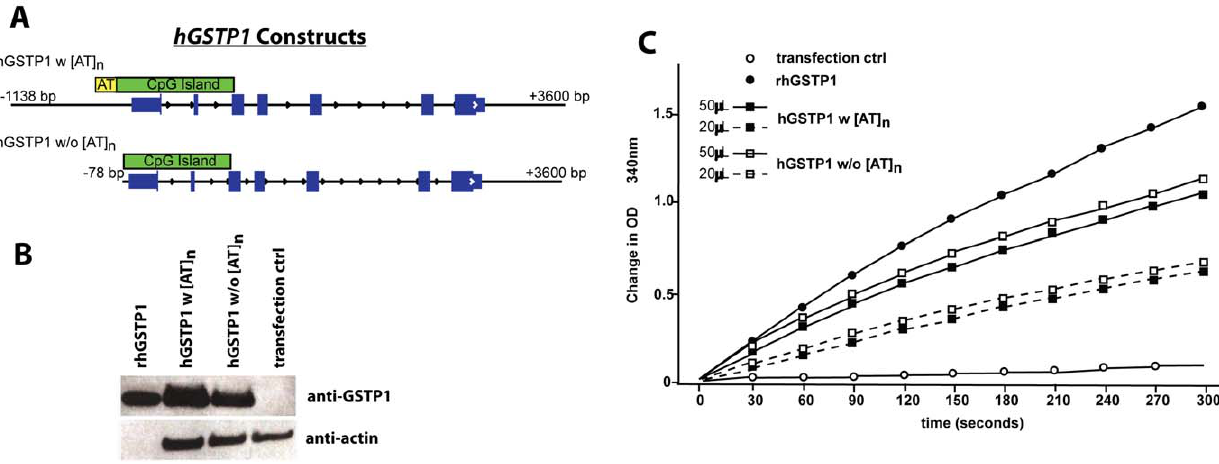
Figure 1. Full length hGSTP1 directs expression of catalytically-active GST p . When transfected into Hep3B cells, which do not express hGSTP1 mRNA or hGSTP1 polypeptides, (A) both full length hGSTP1 ( 2 1138 to + 3600) and hGSTP1 with [ATAAA] n ([AT] n ) repeat sequences deleted ( 2 78 to + 3600) directed expression of (B) GSTP1 polypeptides, as detected by immunoblot analysis, and (C) active GST p , as detected by CDNB assay using the indicated volumes of HEP3B cell lysates, with appearance of the glutathione conjugate of CDNB monitored as change in OD 340 nm . (A–C) Yellow box, position of [AT]n repeat; Green box, position of CpG island; positions are shown with respect to the hGSTP1 transcriptional start site; blue boxes, position of exons; rhGSTP1, recombinant human GSTP1 polypeptides in vitro . Transfection controls directed expression of GFP polypeptides.